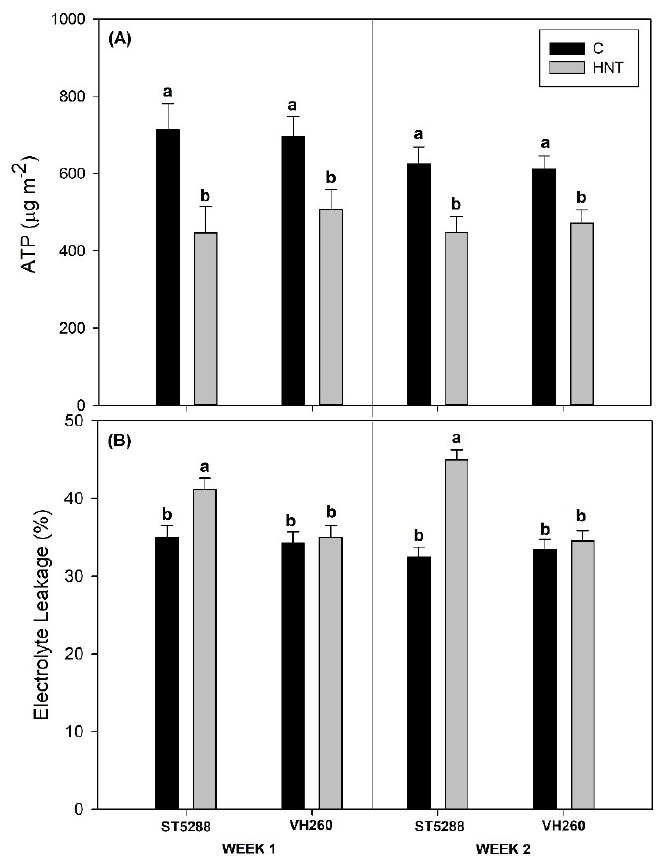
Figure 2. Effect of high night temperatures on subtending leaf ATP levels ( A ) and electrolyte leakage ( B ) at the end of the first and second week after initiation of the treatment. Columns connected with different letters are significantly different ( p = 0.05). Error bars represent ±1 standard error. (C: control temperatures 32/24 °C, HNT: high night temperatures 32/30 °C).